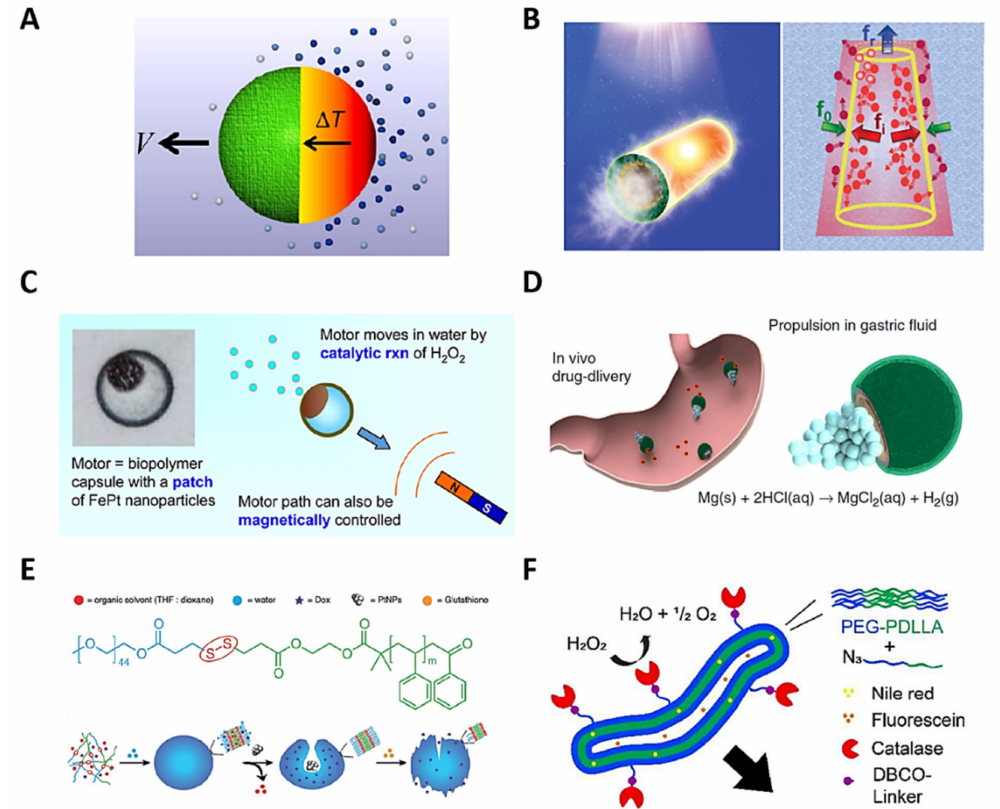
Figure 8. Schematic representation of polymeric micro/nanomotors’ propulsion mechanisms: ( A ) light-propelled JMs, reprinted with permission from [301], copyright 2016, Springer Nature; and ( B ) polymeric tubular rocket, reprinted with permission from [302], copyright 2016, John Wiley and Sons. Magnetic fields and catalytic reactions for propulsion: ( C ) magneto-catalytic polymeric microcapsules, reprinted with permission from [310], copyright 2016, American Chemical Soci- ety; ( D ) catalytic polymeric sphere micromotor, reprinted with permission from [311], copyright 2017, Springer Nature; ( E ) catalytic polymeric stomatocyte nanomotors, reprinted with permis- sion from [312], copyright 2017, John Wiley and Sons; and ( F ) enzymatic polymersome nanomotor, reprinted with permission from [313], copyright 2018, Royal Society of